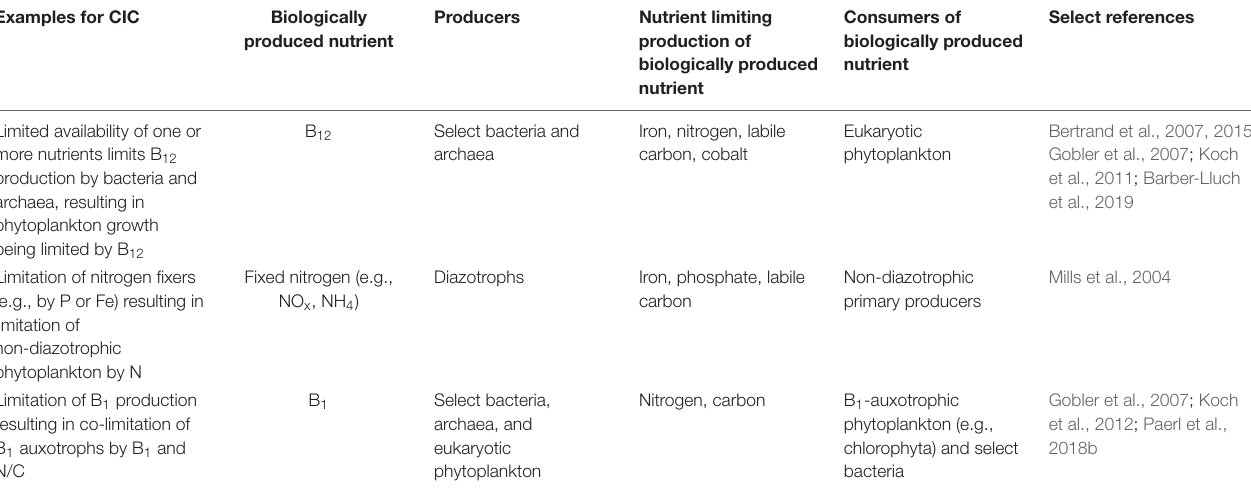
TABLE 1 | Examples of community interaction